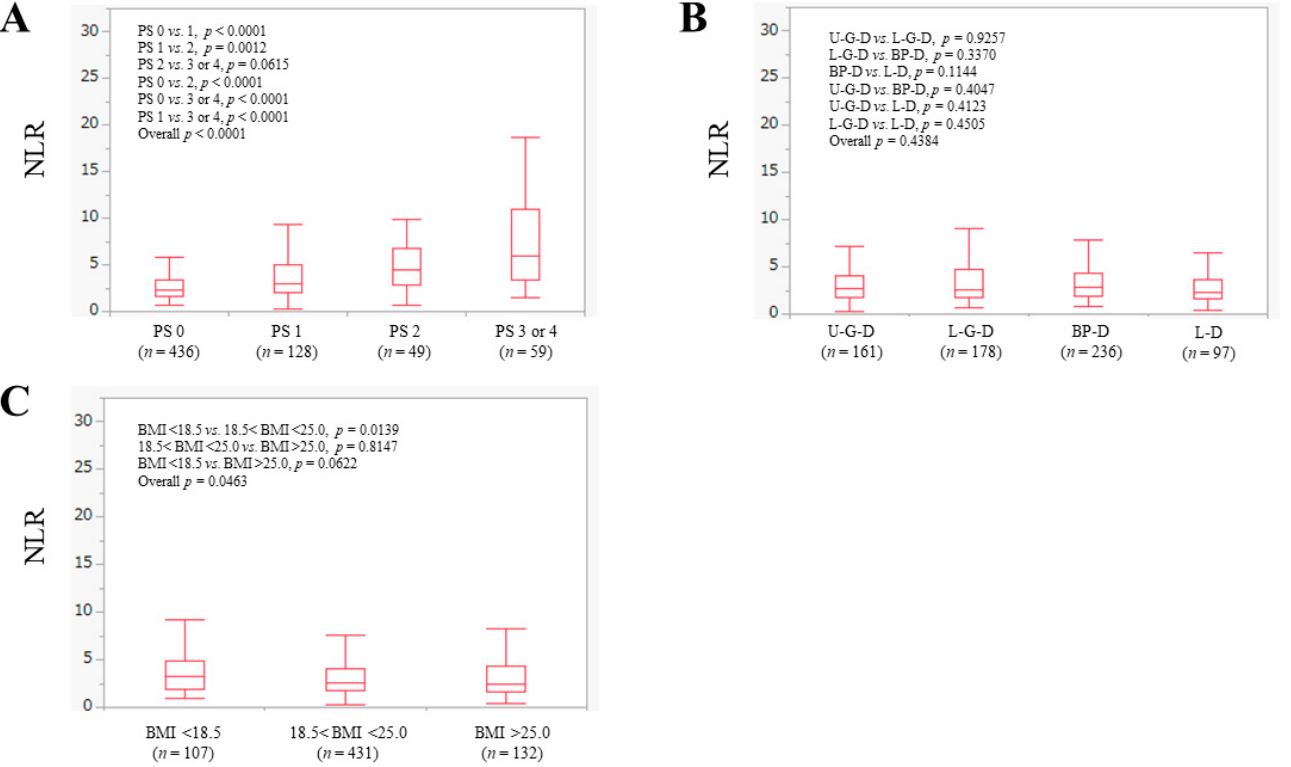
Figure 1. The neutrophil to lymphocyte ratio (NLR) according to ( A ) ECOG-PS, ( B ) anatomical category of disease, and ( C ) body mass index (BMI, kg/m 2 ) in all cases ( n = 672). U-G-D, upper gastrointestinal disease; L-G-D, lower gastrointestinal disease; BP-D, biliary and pancreatic disease; and L-D, liver disease.